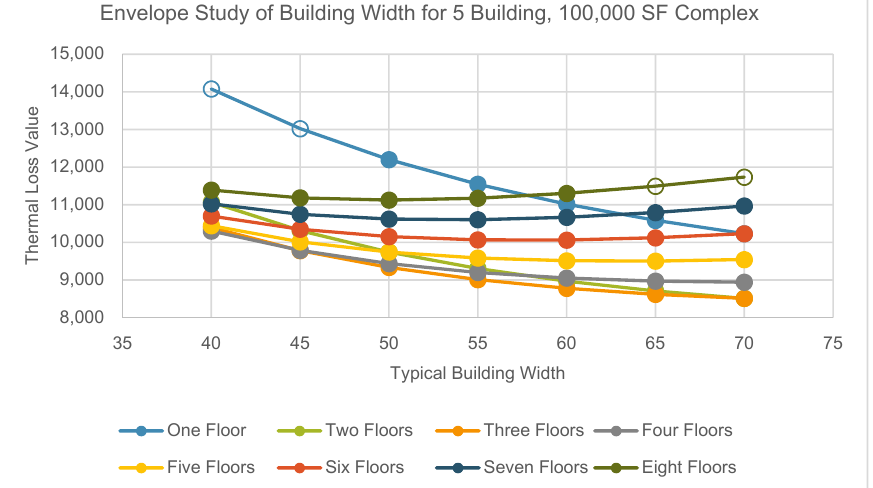
Figure 4. Thermal Loss Value Study of Building Widths with a Constant Total Project Volume and Number of Buildings and Variable Floor Heights.